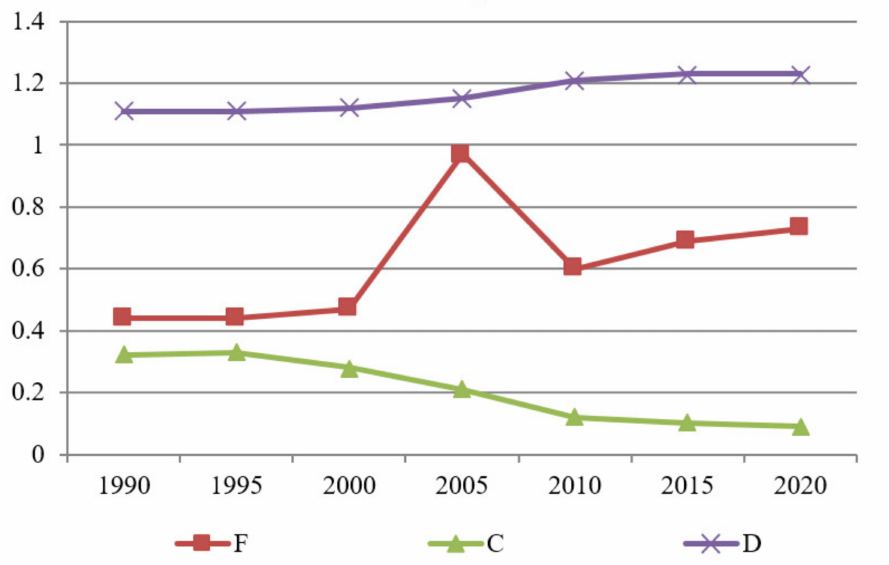
Figure 4. Changes in the land-use form of Ulaanbaatar city (1990–2020).